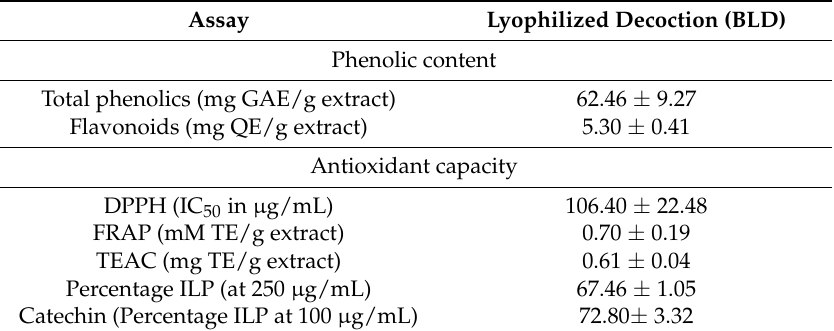
Table 1. The antioxidant, total phenolic and flavonoid content of B. grisebachii